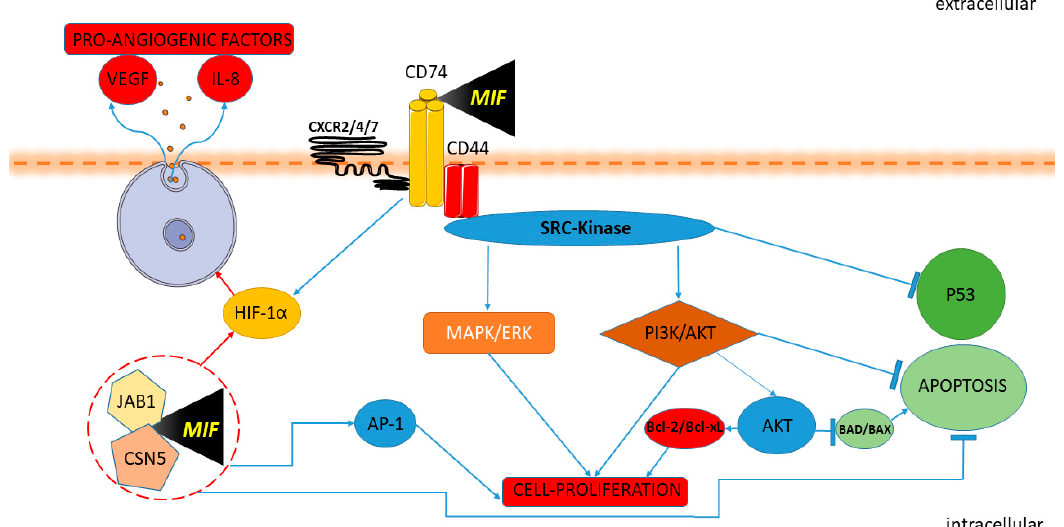
Figure 1. Macrophage migration inhibitory factor (MIF) and cancer pathway. MIF activates the signaling complex binding CD74, CD44 and the chemokine receptors CXCR2, CXCR4, and CXCR7. The Protein Tyrosine Kinase Src is activated by MIF. Upon the engagement of the CD74-CD44 complex, the Src kinase is activated, leading to phosphorylation of the extracellular-signal-regulated kinase ERK / MAP and inhibition of p53 expression. The interaction of MIF and CD74 also promotes the activation of the AKT / PI3K pathway with the consequent inactivation of the pro-apoptotic proteins BAD and BAX and promotes the expression of the anti-apoptotic proteins Bcl-xL and Bcl-2. MIF induces HIF1 α activation through extracellular and intracellular interaction. MIF binding to CD74 leads to HIF1 α activation. In the intracellular domain, MIF binds Jab1 / CSN5, activating HIF1 α and leading to the expression of proangiogenic factors IL-8 and VEGF. MIF modulates AP-1 activity and cell proliferation with Jab1 / CSN5 interaction and inactivating p53.